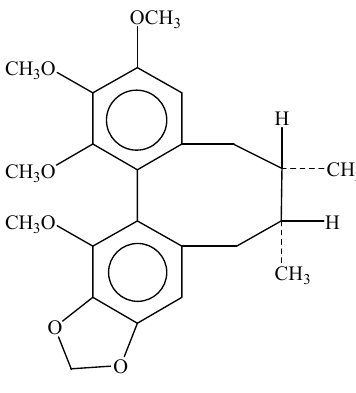
Figure 1. The chemical structure of Sch